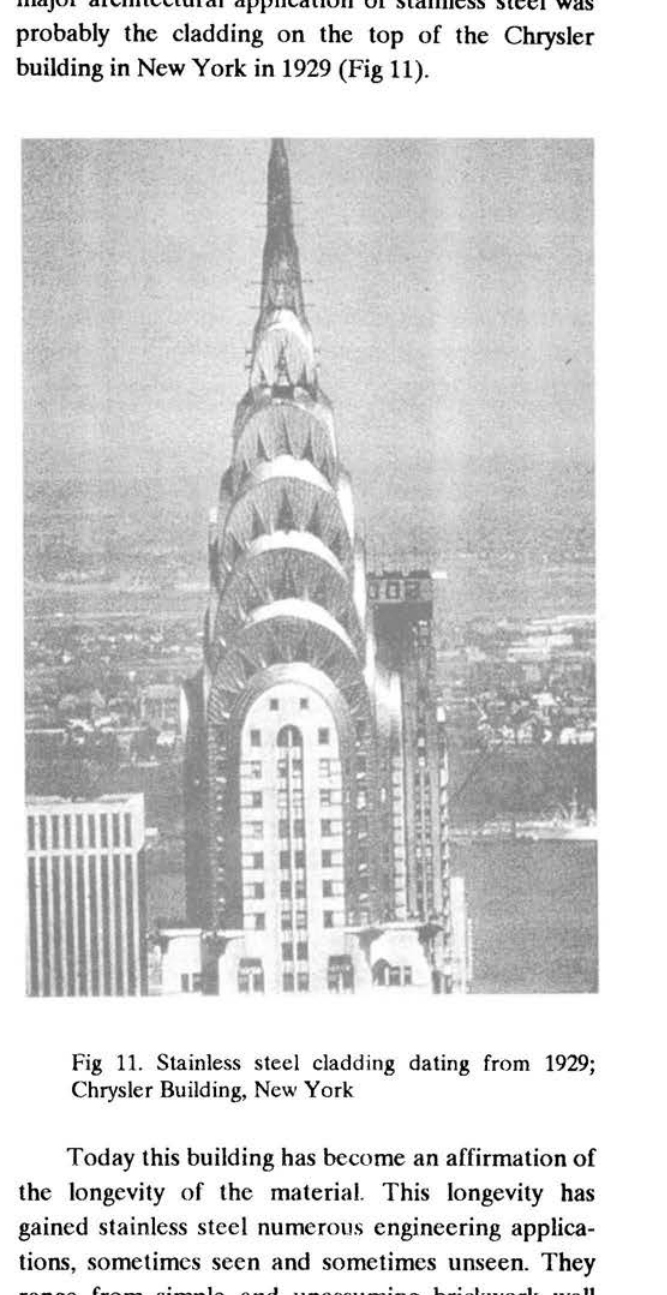
Fig 11. Stainless steel cladding dating from